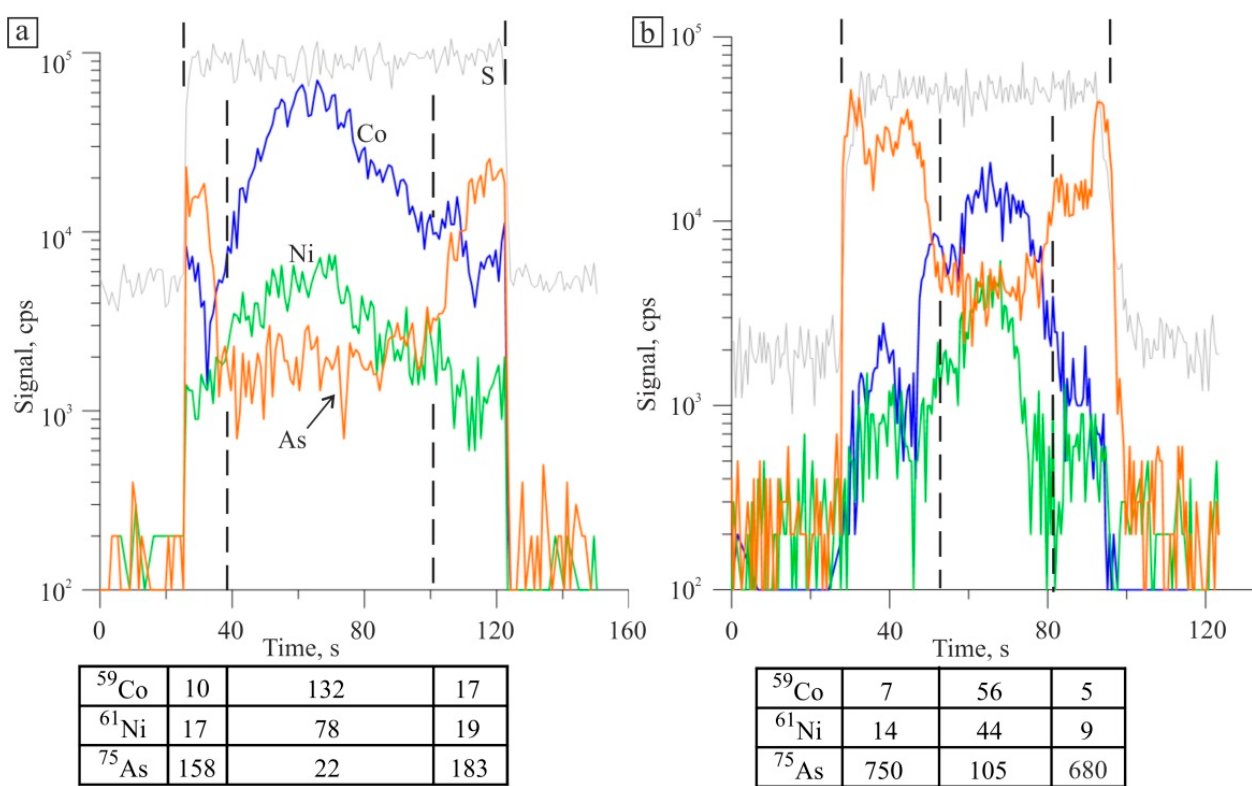
Figure 10. Graphic images of two probing profiles for the pyrite crystals from the sulphide-quartz veins of the Ilyinskaya dyke, the Berezovsk deposit. Here, and in the Figures 11 and 13, the y-axis is signal (counts per second) and x-axis is time (in seconds). Profiles length: ( a ) 482 µ m, ( b ) 330 µ m. Average content of elements (ppm) in the profile intervals in the table below each figure is indicated (here and in Figures 11 and 13).